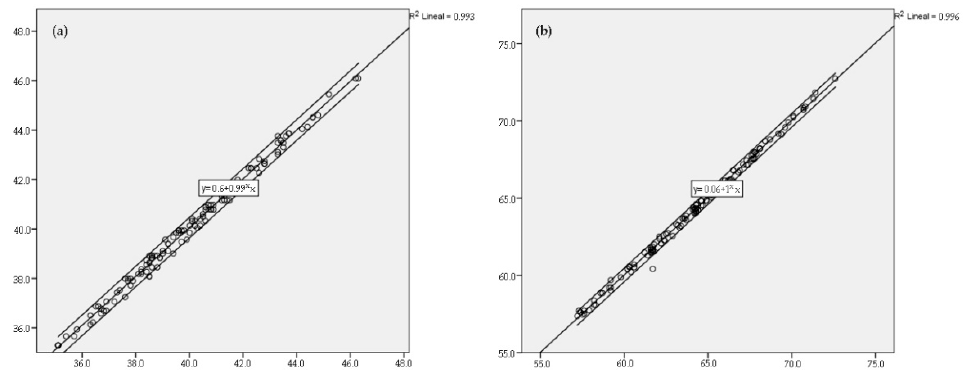
Figure 3. Correlational analysis between the ideal height of the chair calculated with an anthro- pometer and the ideal height of the chair with ISHT ( a ), and correlational analysis of the ideal height of the desk calculated using the anthropometer and ideal height of the desk using IDHT ( b ).